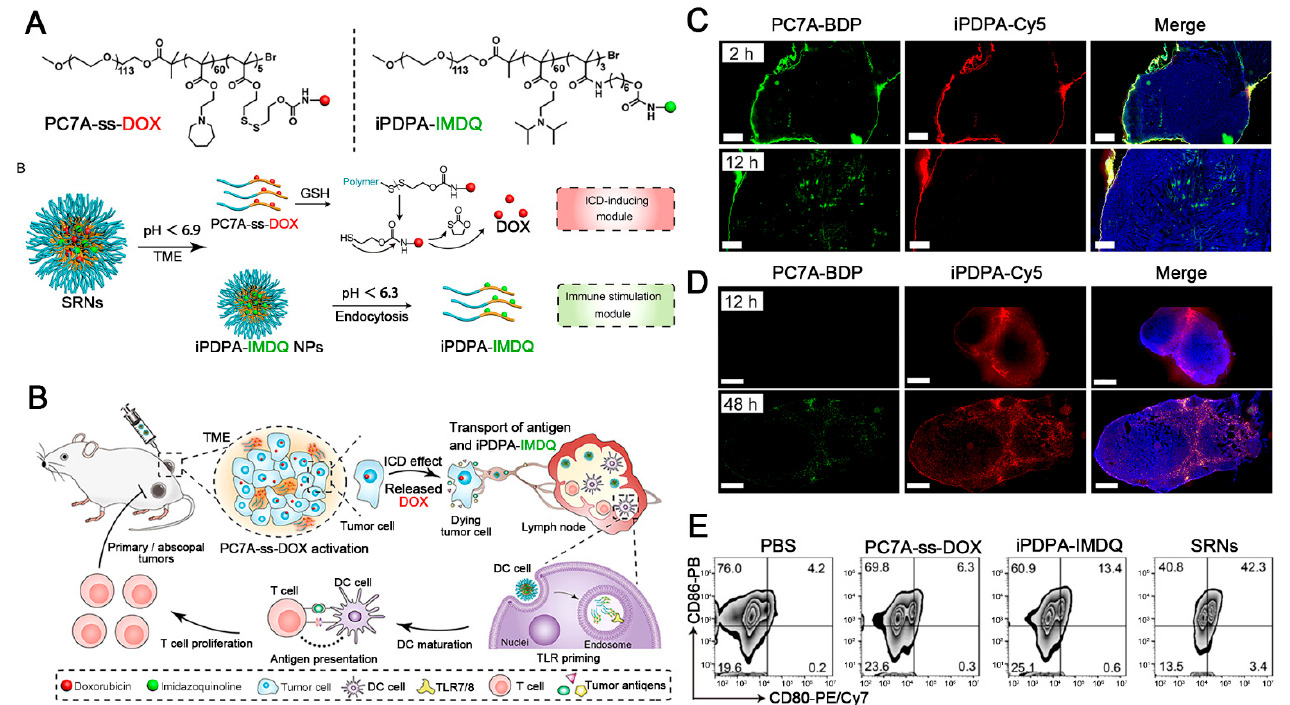
Figure 5. Schematic of SRNs for cancer immunotherapy. ( A ) Schematic of the structure of two pro- drugs and the pH-responsive behavior for sequential drug release. ( B ) Schematic of sequential activation mechanisms of immune response after peritumoral injection with SRNs in the tumor-bearing mice. ( C ) Representative images of tumor tissues at 2 and 12 h after peritumoral injection with SRNs. ( D ) Representative images of lymph nodes tissues at 12 and 48 h after peritumoral injection with SRNs. ( E ) Expression levels of CD80 and CD86 on DCs after treatment of SRNs. Reprinted with permission from ref. [143] . Copyright 2021, copyright American Chemical Society.